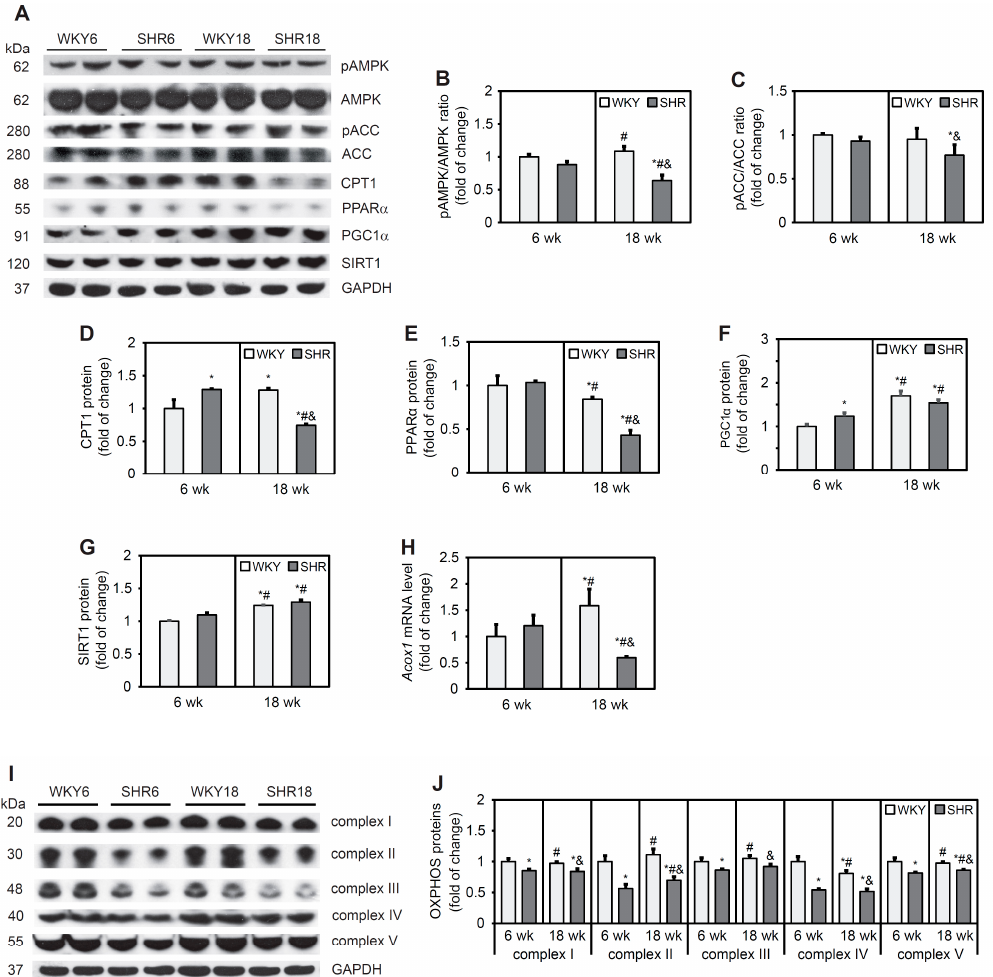
Figure 4. Expression of proteins that are involved in fatty acid oxidation and proteins of respiratory chain complexes. AMP-activated protein kinase (AMPK) ( A , B ), acetyl-CoA carboxylase (ACC) ( A , C ), carnitine palmitoyltransferase 1 (CPT1) ( A , D ), peroxisome proliferator-activated receptor α (PPAR α ) ( A , E ), peroxisome proliferator-activated receptor γ coactivator 1 α (PGC1 α ) ( A , F ), sirtuin 1 (SIRT1) ( A , G ), and OXPHOS ( I , J ) protein levels and phosphorylation of AMPK ( A , B ) and ACC ( A , C ) were determined by Western blot analysis. Acox1 mRNA levels ( H ) were measured by real-time PCR. The results are expressed as mean ± SD. n = 10; in the case of Western blot analysis LV form 5 rats were merged in one sample and 3 different gels were run. * p < 0.05, vs. WKY6 group; # p < 0.05, vs. SHR6 group; & p < 0.05, vs. WKY18 group.